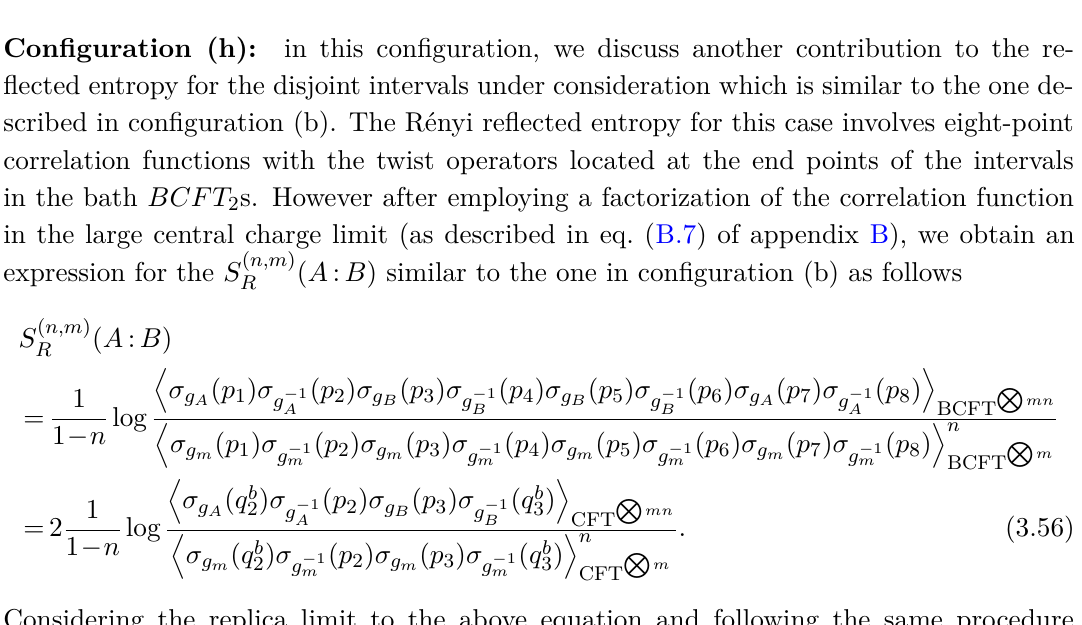
Figure 26 . The endpoints of the intervals A and B add the image points in the two BCFT 2 copies are identified similarly as in figure